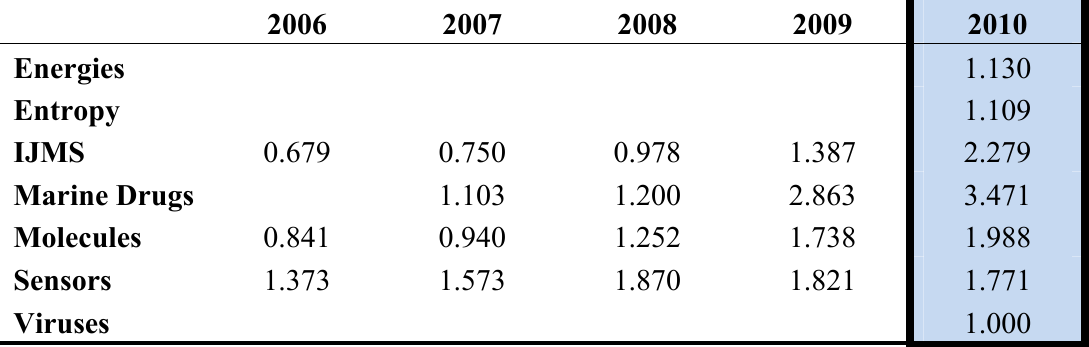
Table 1. Impact Factors of seven MDPI journals [adapted from the Journal Citation Reports (JCR), Edition 2010, Copyright 2011 by Thomson